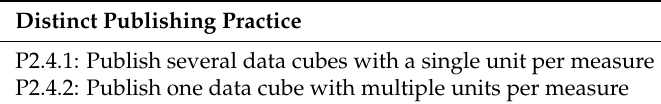
Table 25. Distinct practices of data portals for selecting number of units per measure. Distinct Publishing